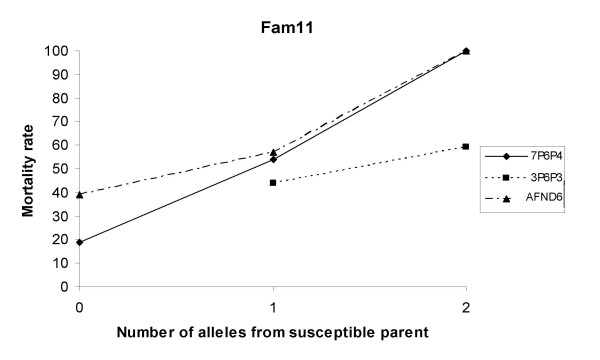
Plot of mortality rate as a function of alleles inherited from the susceptible parent in family 11 for significant markers on chromosome 2.